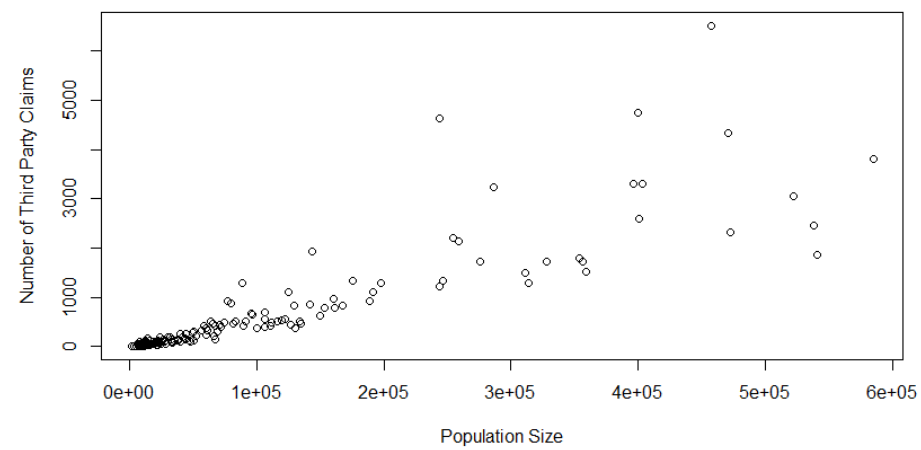
Figure 3. Scatterplot of the Model 2 data.